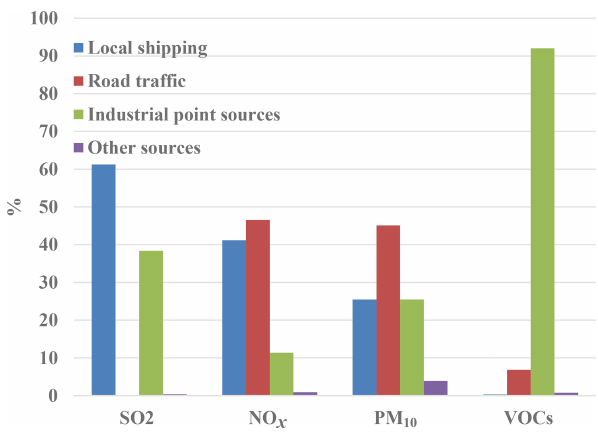
Figure 3. Proportions of different source categories in the local emission inventory for the city-scale model domain in the year 2012. The total emissions are 502tyr − 1 for SO 2 , 5072tyr − 1 for NO x , 357tyr − 1 for PM 10 and 7457tyr − 1 for